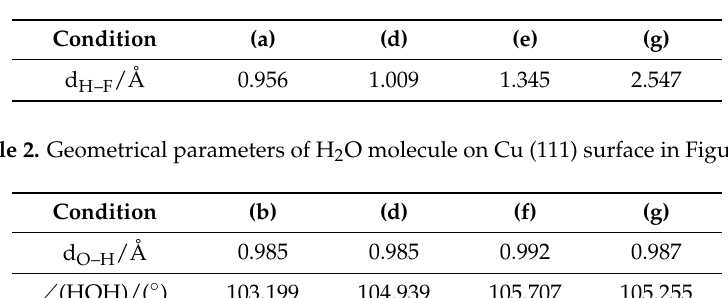
Table 1. Geometrical parameters of HF molecule on Cu (111) surface in Figure 2.